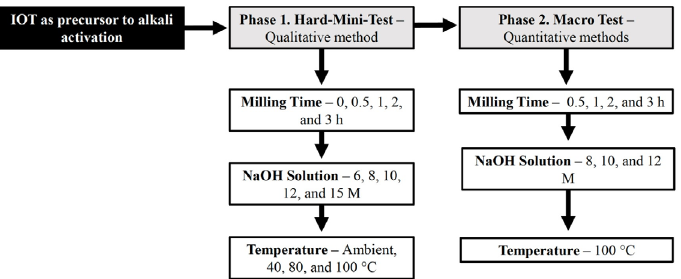
Figure 2. Schematic of the experimental